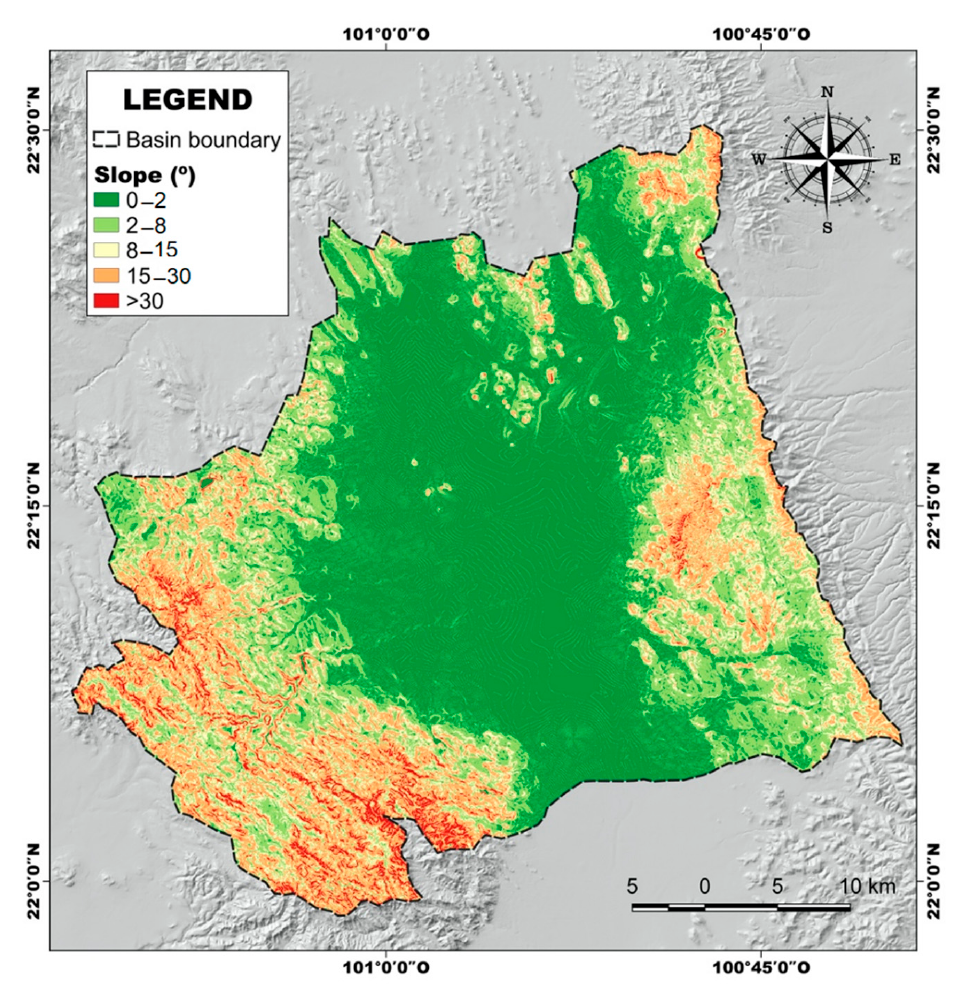
Figure 5. Slope map of the San Luis Potosi Basin.